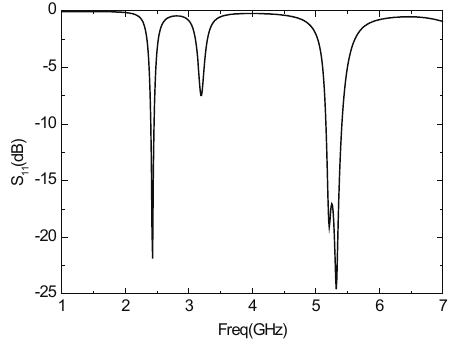
Figure 21. S 11 parameter curve of the improved antenna.